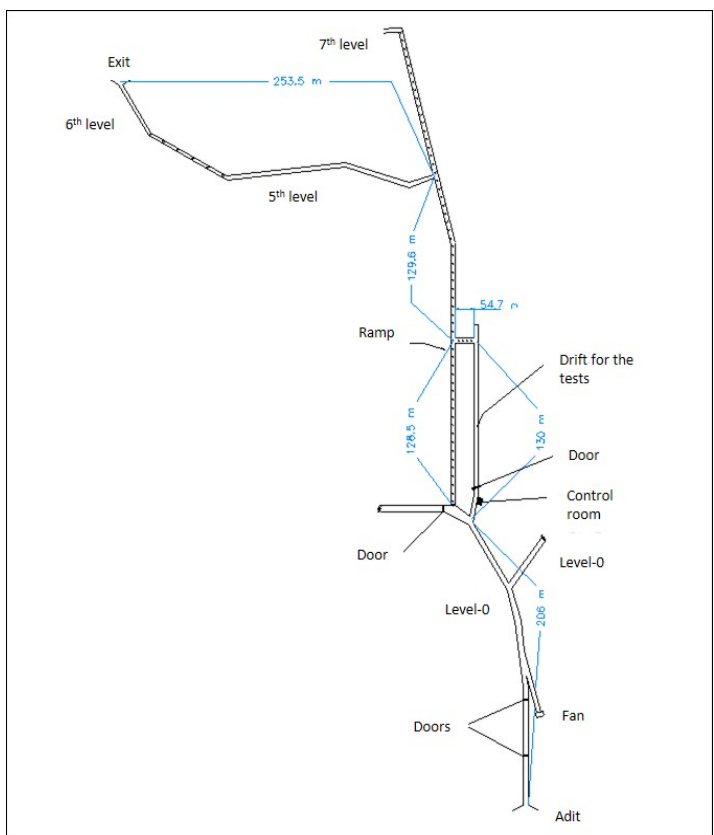
Figure 1. Scheme of the facilities.